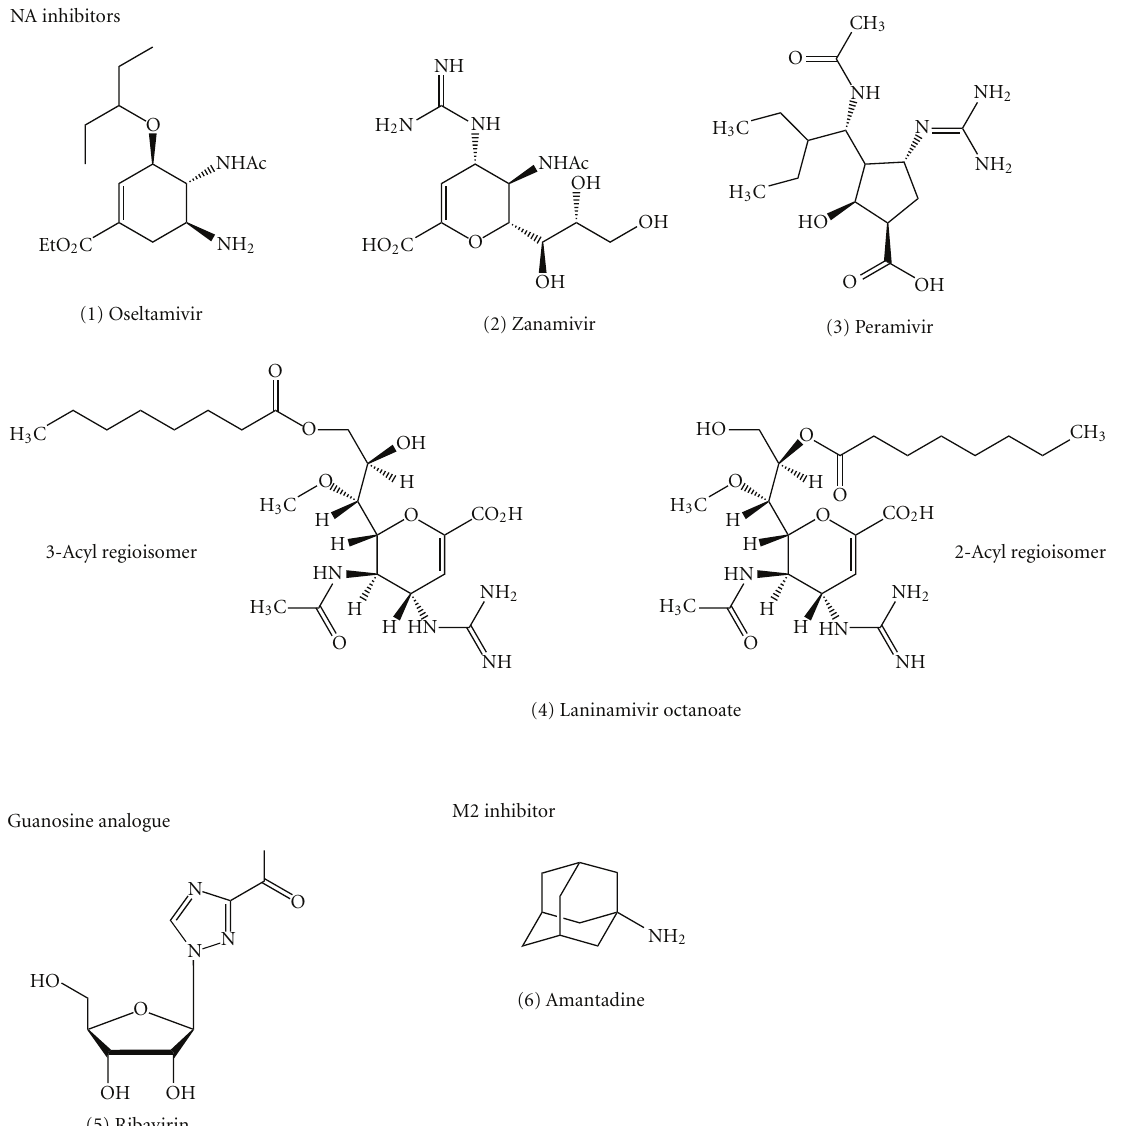
Figure 1: List of anti-influenza drugs currently